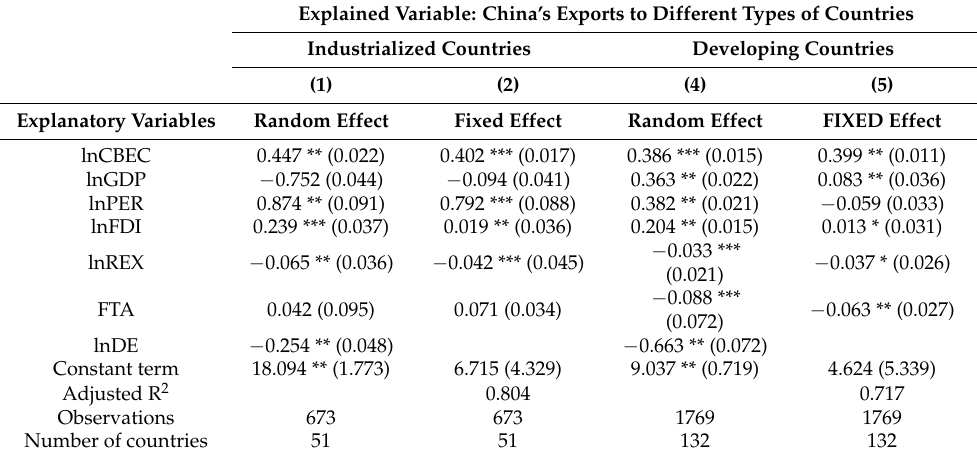
Table 4. Grouped regression results of developed and developing countries.